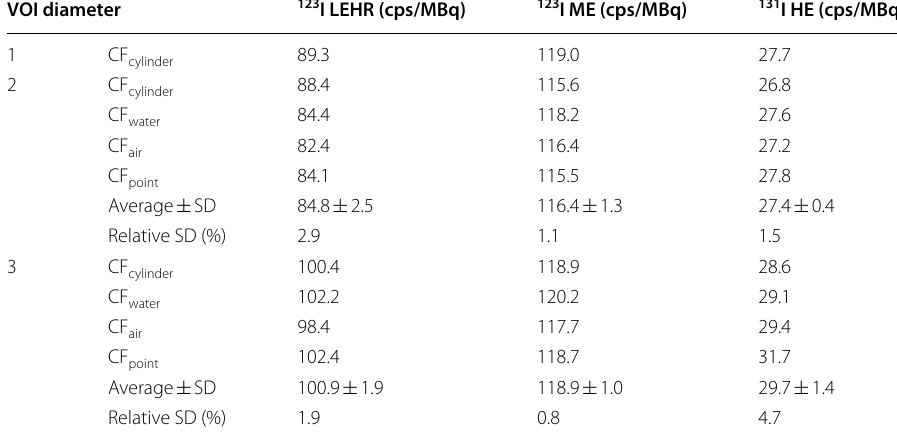
Table 1 CFs for 123 I with the LEHR and ME collimator and 131 I with the HE collimator, in cps/MBq, for the four CF source